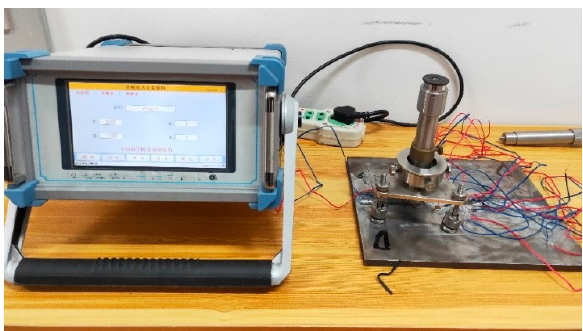
Figure 3. Sample morphology.